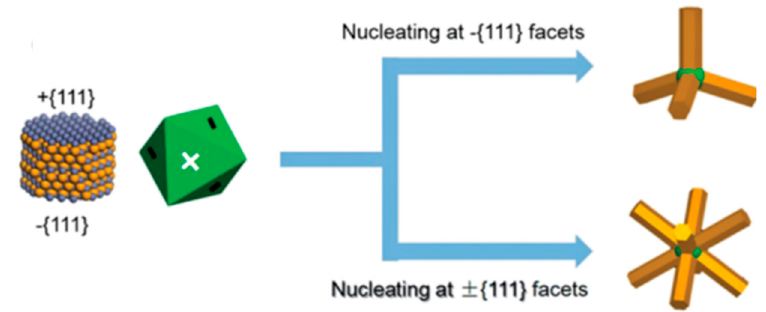
Figure 12. Schematic illustration of the growth of TP heterostructures. Reproduced with permission from [139]. Copyright Copyright RSC, 2014.